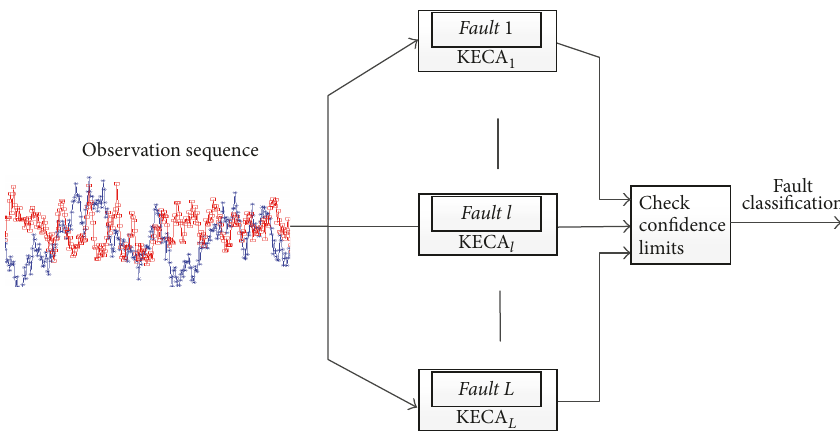
Figure 1: Architecture of the KECA-based fault detection